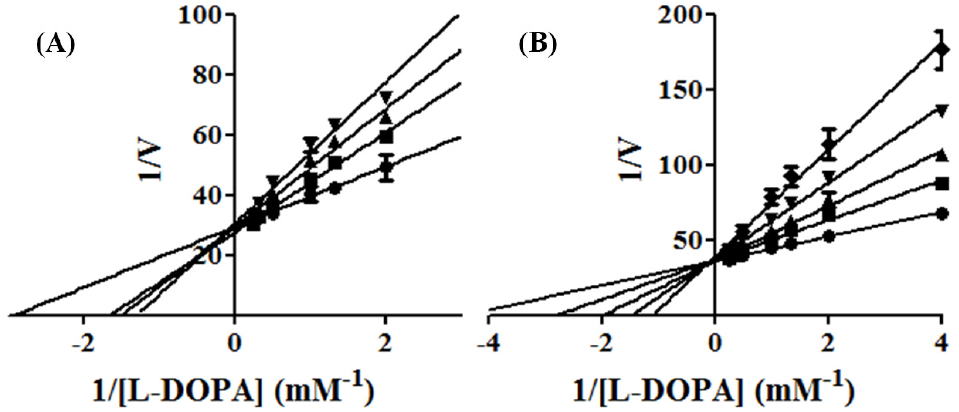
Figure 2. Lineweaver-Burk plot on the oxidation of L-DOPA by tyrosinase with INH2 ( A : 0 [ ● ]; 0.05 [ ■ ]; 0.1[ ▲ ] and 0.2 [ ▼ ] mM) and with INH4 ( B : 0 [ ● ]; 0.025 [ ■ ]; 0.5 [ ▲ ]; 0.1 [ ▼ ] and 0.2 [ ♦ ]